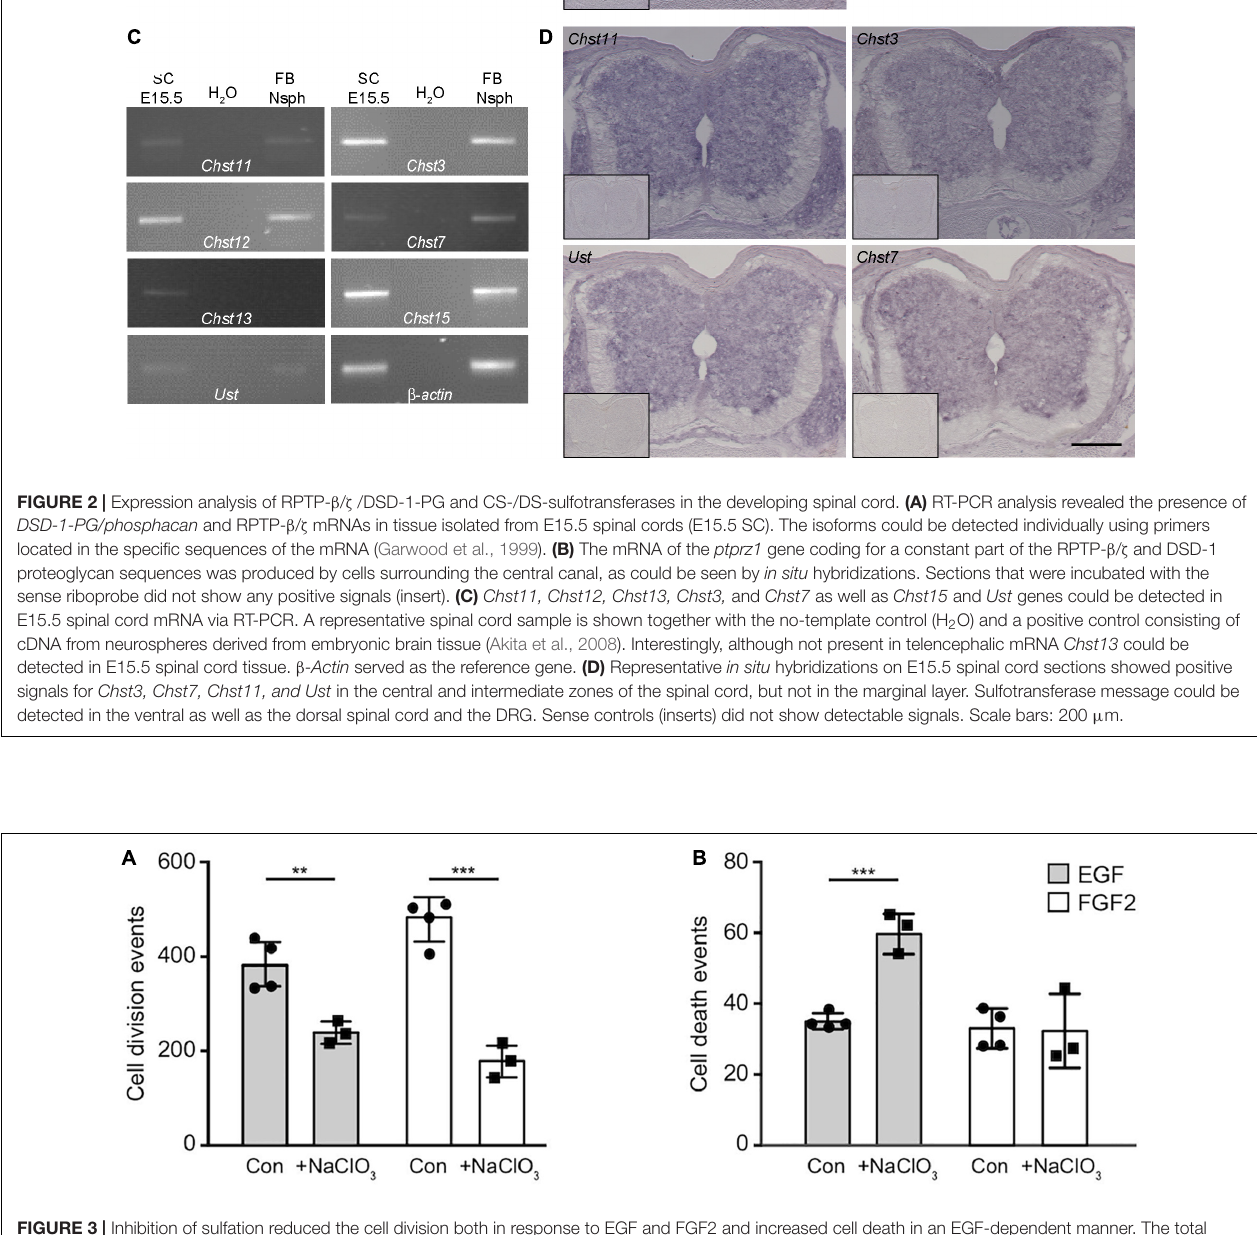
Frontiers in Cell and Developmental Biology |